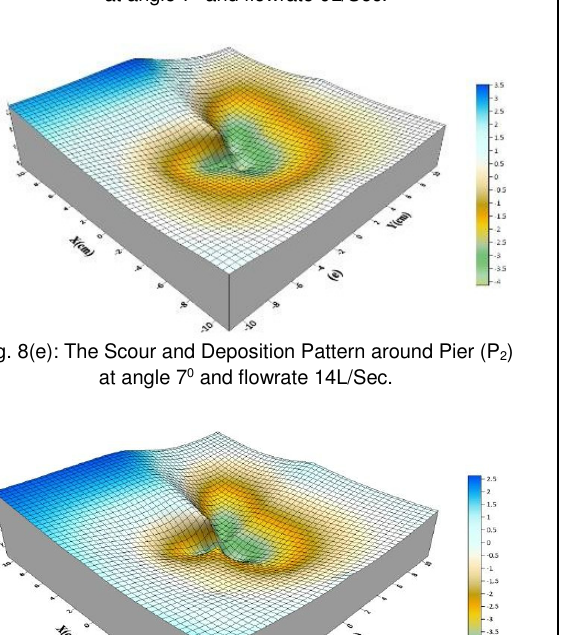
Fig. 8(d): The Scour and Deposition Pattern around Pier (P 2 ) at angle 7 0 and flowrate 9L/Sec.